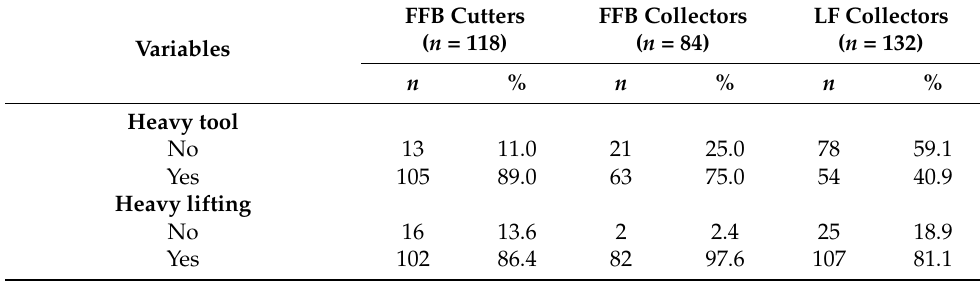
Table 2. Ergonomics risk factors in oil palm harvesting workers ( n =